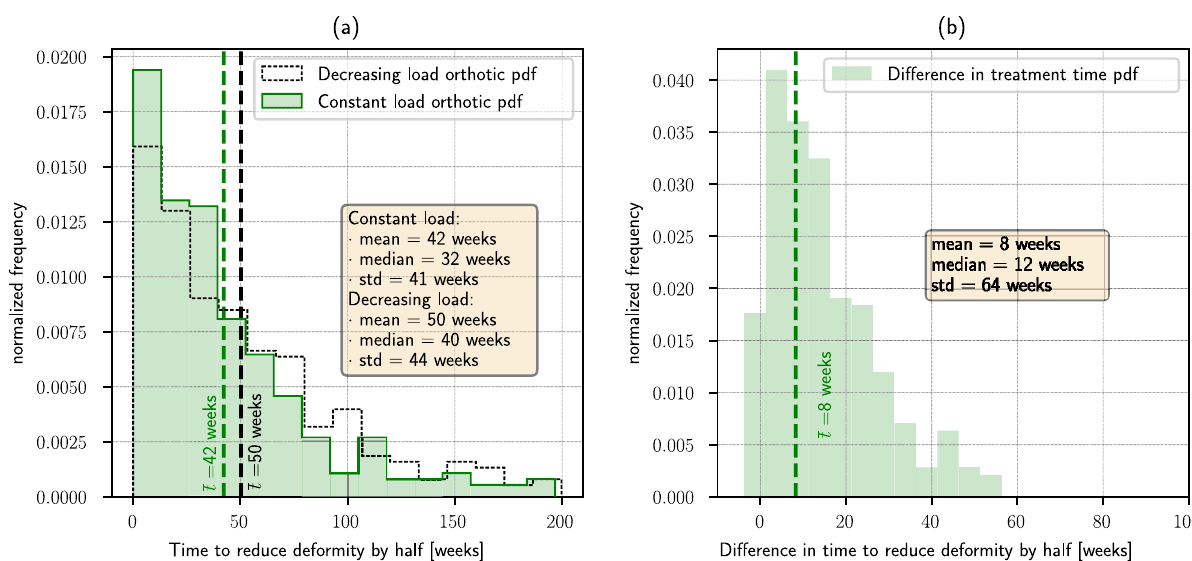
Figure 6. Time necessary to reduce an initial knee deviation by half. ( a ) Comparison of the pdf of necessary time, for a constant load and a decreasing load orthotic. ( b ) Pdf of the difference in wearing time for a constant load and a decreasing load orthotic. With a probability greater than 50%, treatment time for reducing deformity by half is 12 weeks shorter with a constant load